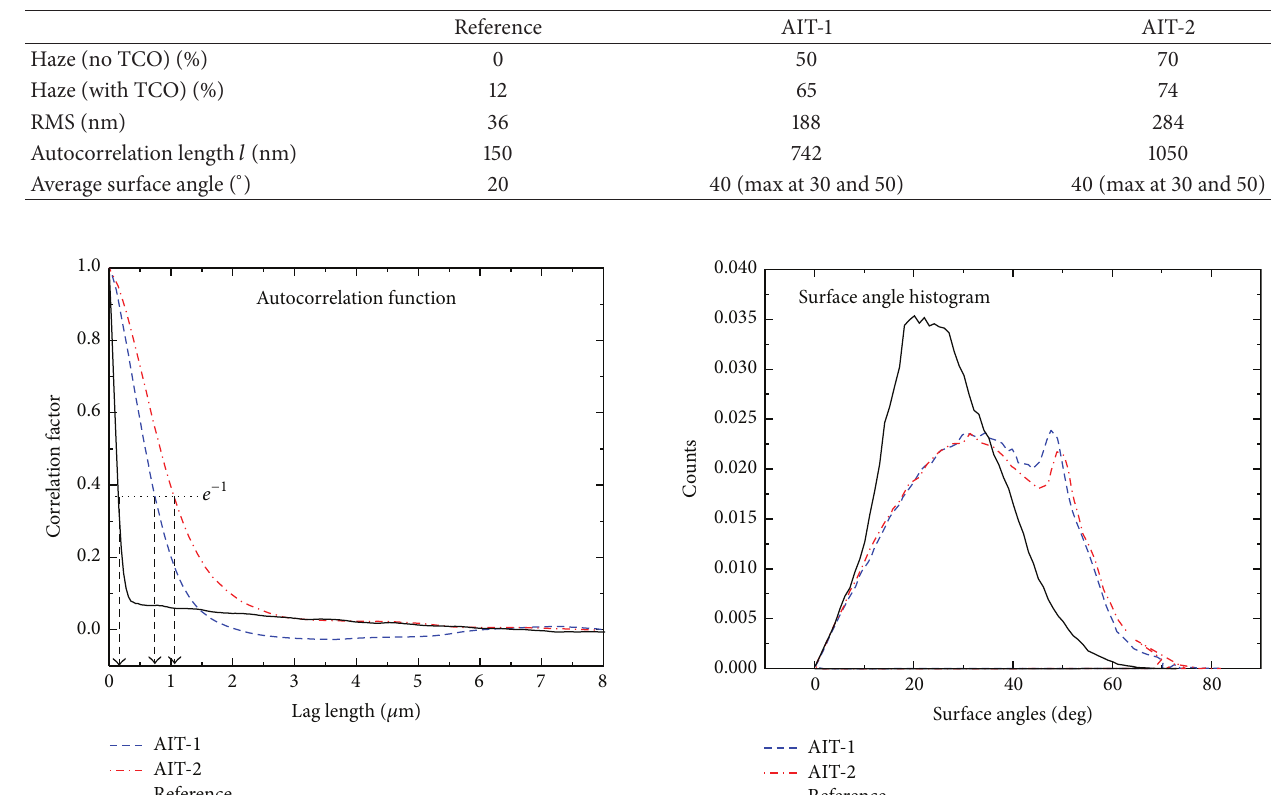
Table 1: Measured haze values of visible light and calculated surface morphology parameters for the different superstrates used. With the exception of haze, all parameters were measured after TCO deposition and TCO texturing; that is, the AIT glass superstrates are double- textured (microtextured glass covered with nanotextured TCO).